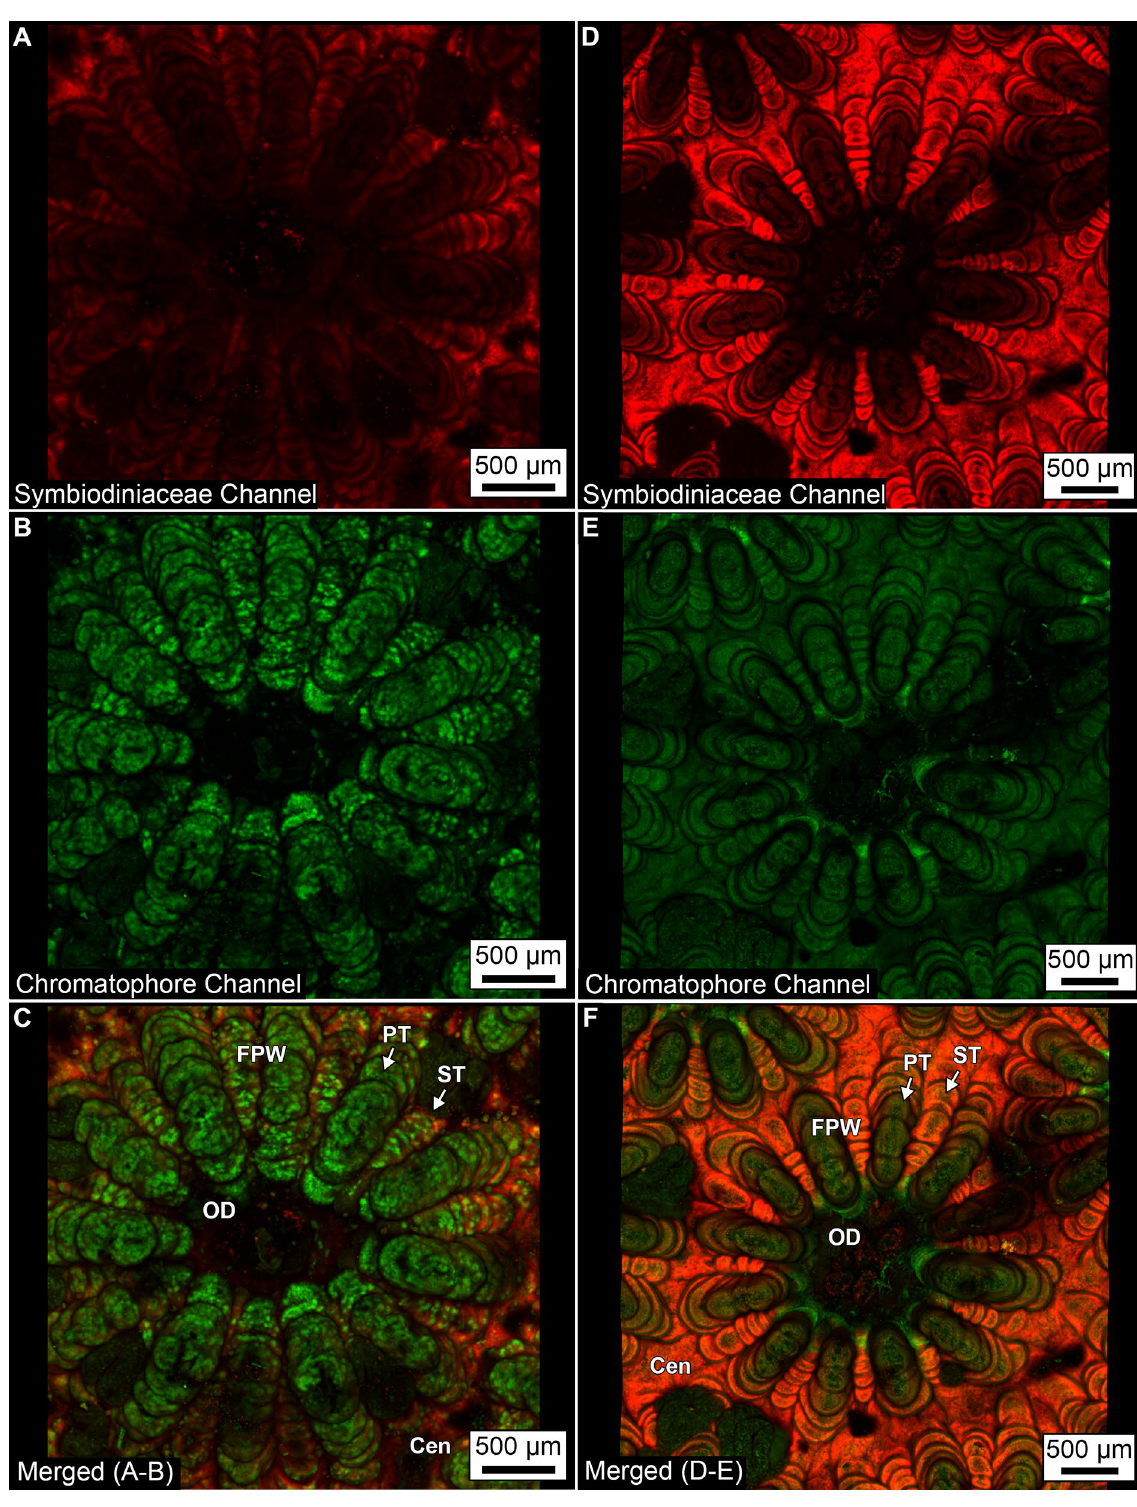
Figure 4. Three-dimensional (3D) two-photon laser scanning microscopy comparing the distribution and abundance of Symbiodiniaceae and chromatopores within and around single polyps of O. annularis (A, B, C) and O. faveolata (D, E, F). Chromatophore authofluorescene (pseudo-colored green) and Symbiodiniaceae autofluorescence (pseudo- colored red) is reconstructed in 3D from serial optical sections. ( A ) Symbiodiniaceae autofluorescene in O. annularis . ( B ) Chromatophore autofluoresence in O. annularis . ( C ) Superimposed images of A and B (see also Supplementary Movie 1). ( D ) Symbiodiniaceae autofluorescence in O. faveolata . ( E ) Chromatophore autofluorescence in O. faveolata. ( F ) Superimposed images of D and E (see also Supplementary Movie 2). Intensities of images in green and red channels were set at the same range (0-149 grey scale in 8 bit) for comparision between species. Lables include: Cen– ceonosarc; FPW–folded polyp wall; PT–primary tentacle; ST–secondary tentacle; and OD–oral